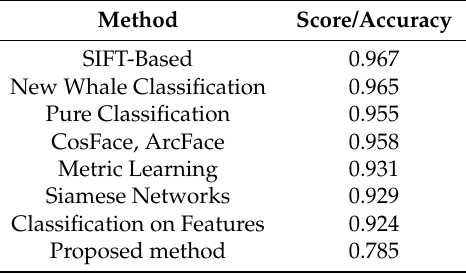
Table 2. State-of-the-art of Kaggle competition models vs. proposed model. Note that Kaggle submissions are evaluated according to the Mean Average Precision @ 5 (MAP@5). Proposed method uses a straight forward convolutional neural network, main advantages are the low resources needed and fast training process to be embedded in a small computing device. The method is not the best one but it has a good accuracy.